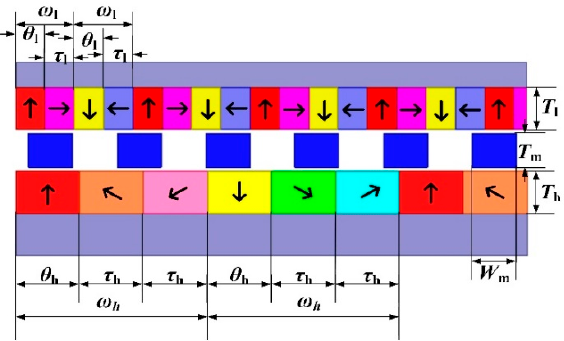
Figure 4. The dimensions of the HAMG.